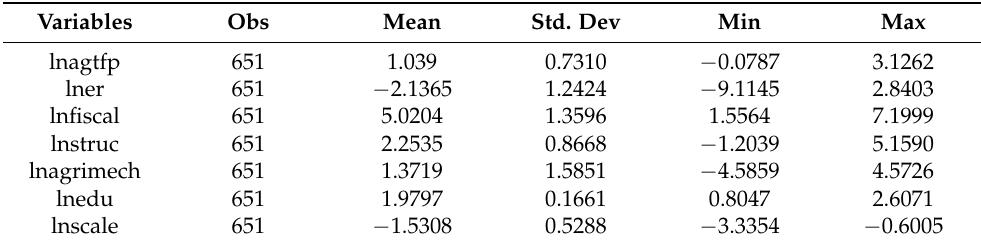
Table 3. Descriptive statistics of